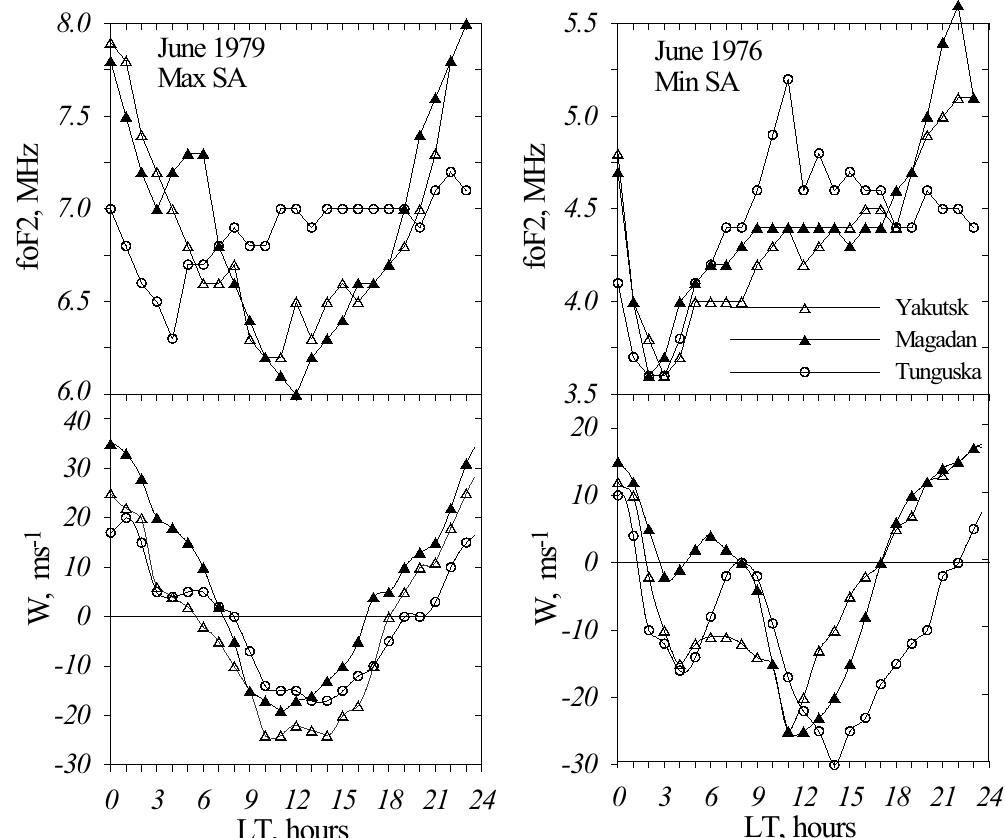
Figure 5. Observed monthly median foF 2 diurnal variations at Yakutsk and Magadan (stations inside the anomaly area) and Tunguska (a station outside the anomaly area) under solar maximum (1979) and solar minimum (1976) conditions (top panel). Bottom panel—inferred diurnal variations of vertical plasma drift.